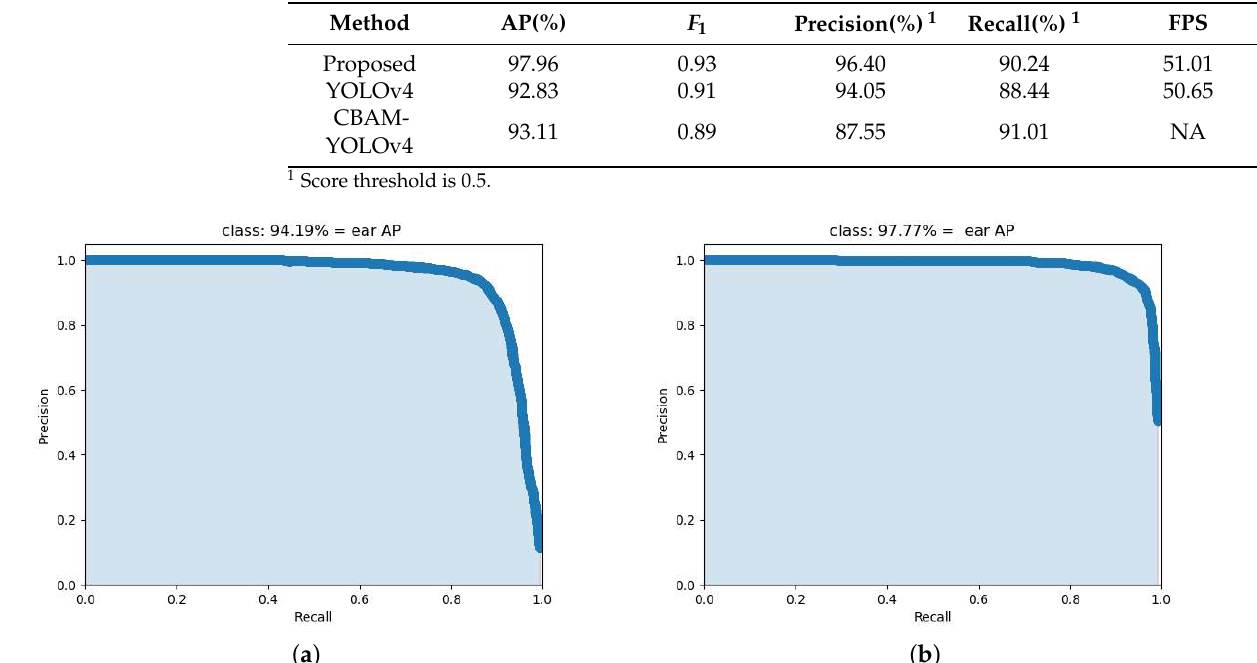
Table 2. Performance evaluation result comparison with GWHD dataset.